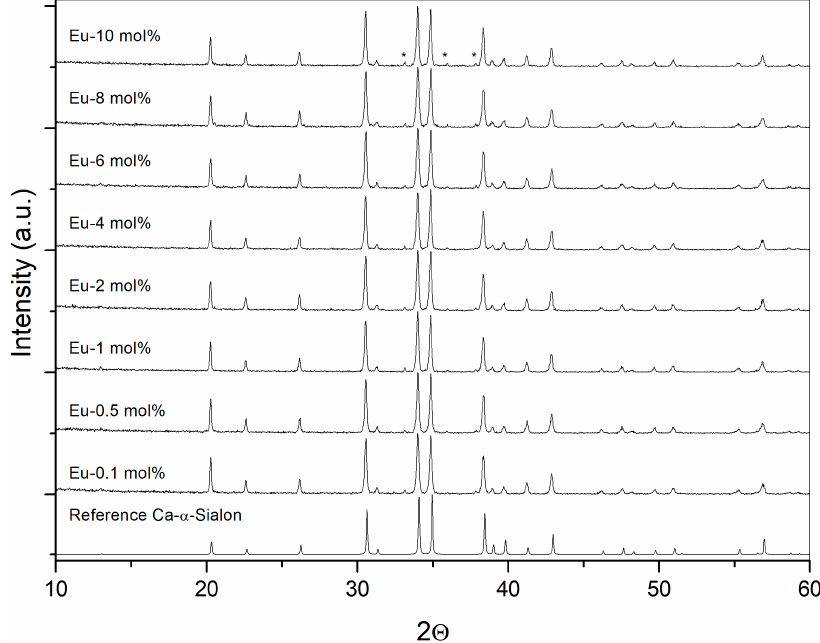
Figure 1. X-ray diffraction patterns of Ca (0.8 − x) Eu x Si 9.6 Al 2.4 O 0.8 N 15.2 phosphors (0 < x < 0.08). Asterisk indicates AlN related peaks.